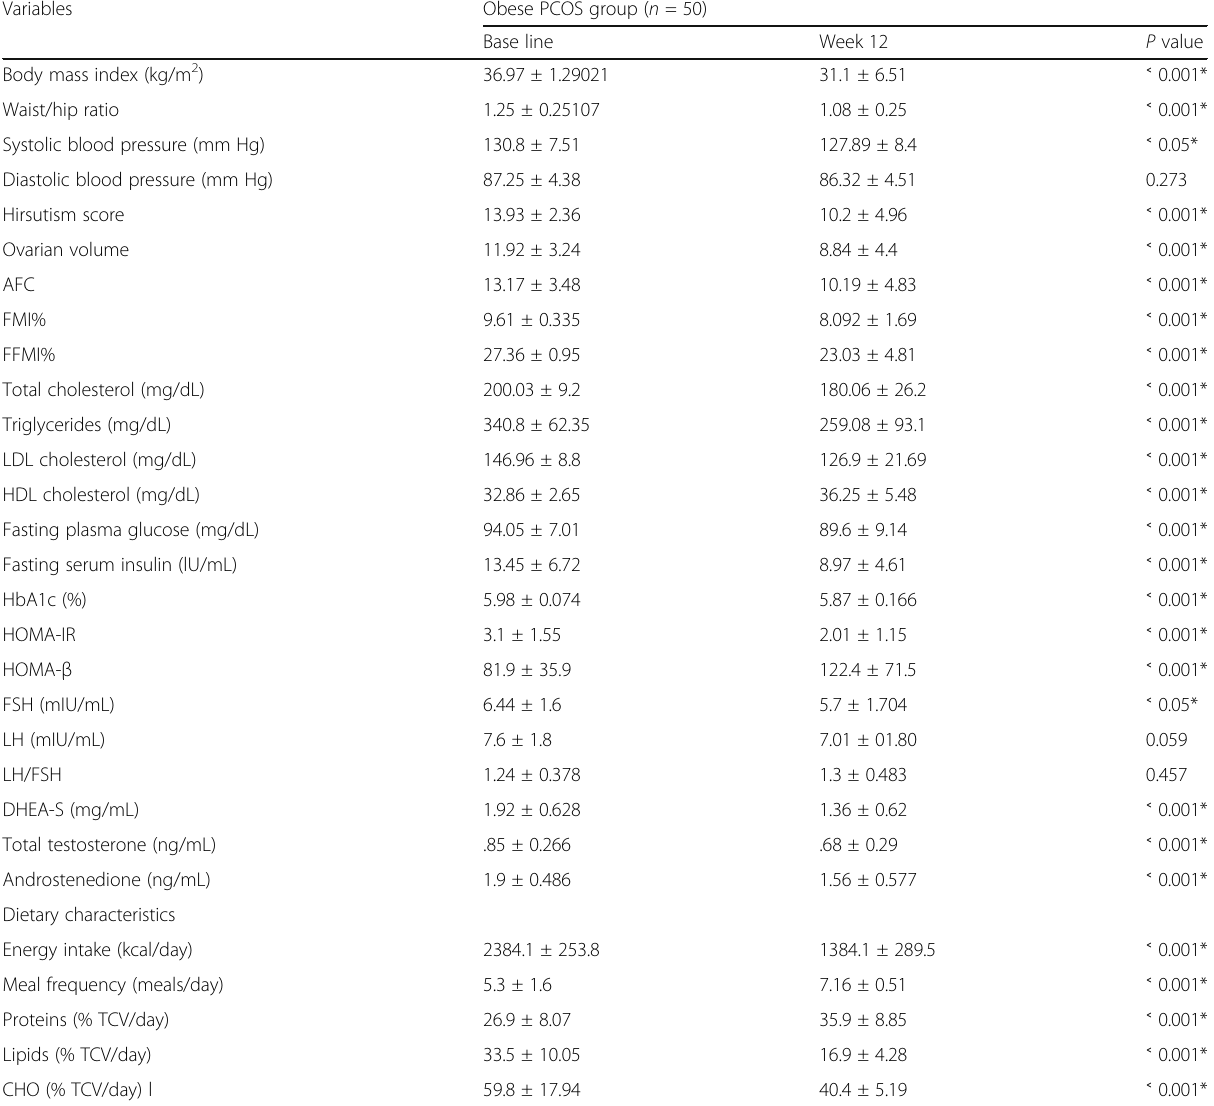
Table 3 The impact of weight loss on clinical and phenotype characteristics of obese PCOS group